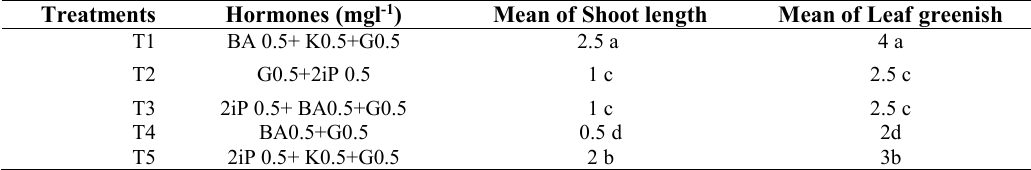
Table 5. Effect of hormone treatments on shoot length and leaf greenish means in Duncan grouping